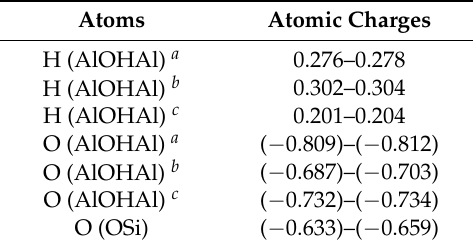
Table 1. Net atomic charges of the main atoms of halloysite calculated with the QEq method. Atoms